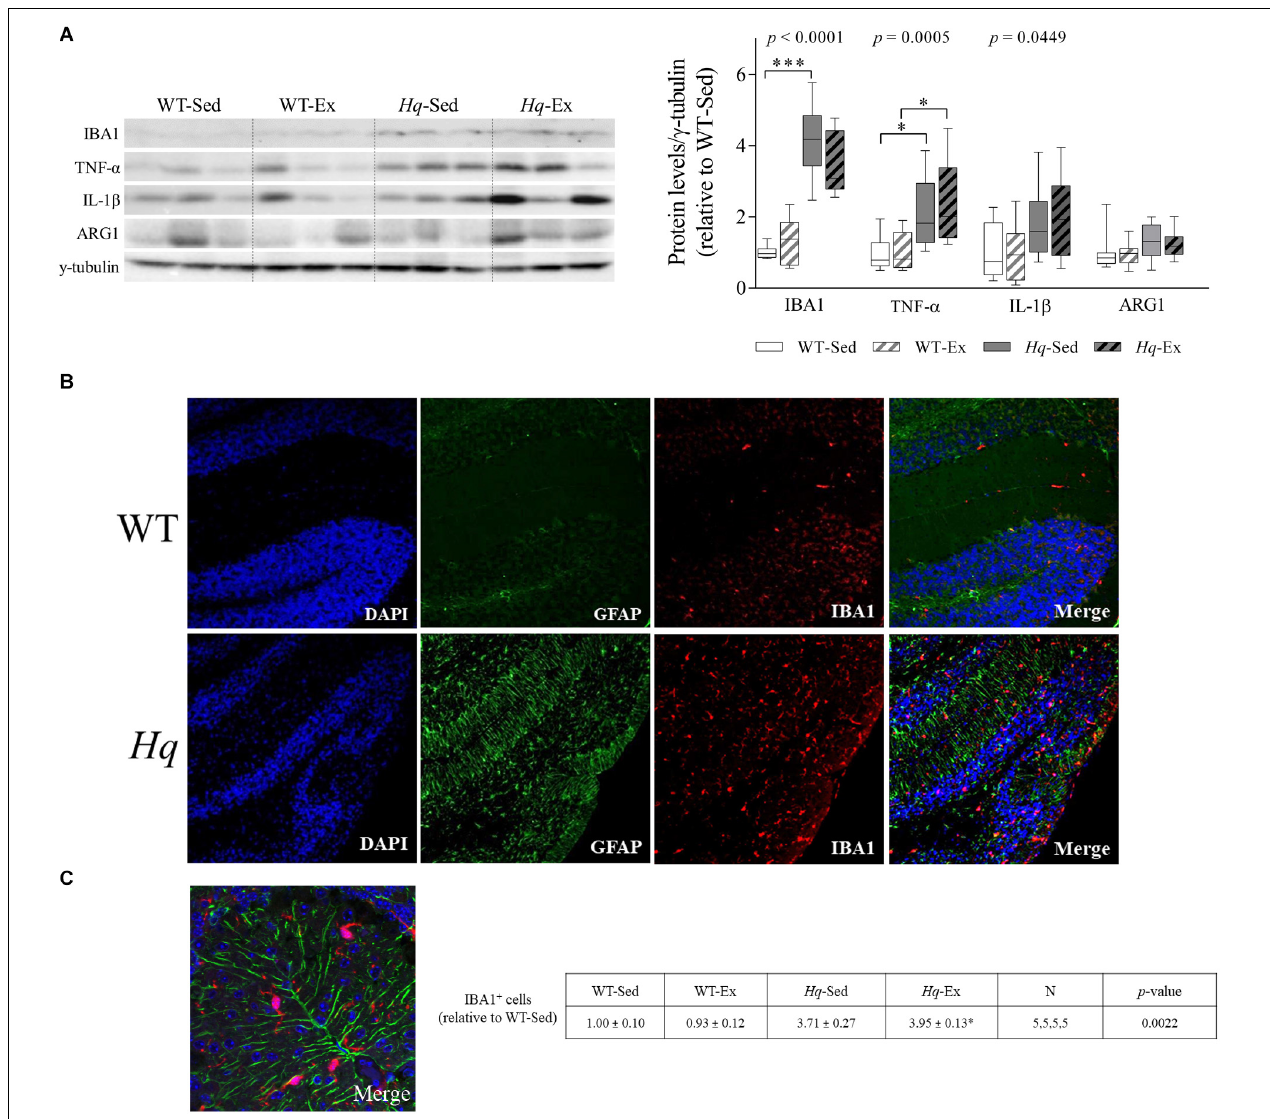
FIGURE 7 | Microglial activation and polarization markers. (A) Western blot analysis of ionized calcium binding adapter molecule 1(IBA1), tumor necrosis factor α (TNF- α ), interleukin 1 β (IL-1 β ), and arginase 1 (ARG1) in cerebellum homogenates of wild-type sedentary (WT-Sed, n = 12) and exercise-trained (WT-Ex, n = 11) mice, and of Hq sedentary ( Hq -Sed, n = 11) and exercise-trained ( Hq -Ex, n = 10) mice. Densitometry analysis: protein levels were normalized to γ -tubulin levels; data (median, interquartile range, and min and max values) are expressed relative to levels in the WT-Sed group. Significant p- values for the group effect (Kruskal-Wallis test) are shown above the corresponding boxes. Symbols for significant differences in post hoc pairwise comparisons: ∗ p < 0.05; ∗∗∗ p < 0.001 for Hq -Sed vs. WT-Sed, and Hq -Ex vs. WT-Ex. (B) Immunofluorescence analysis of cerebellar cortex for detection of GFAP (green), and IBA1 (red), and nuclei (blue), and merged images in representative sedentary WT and Hq mice (10 × ). Analyses were performed in 5 animals for each experimental group, 1 slide per animal. Only representative WT-Sed and Hq -Sed images are shown for simplicity purposes, due to absence of training-induced effect. (C) Higher magnification image of a representative sedentary Hq mouse showing activated microglial cells in both granule and molecular layers (63 ×